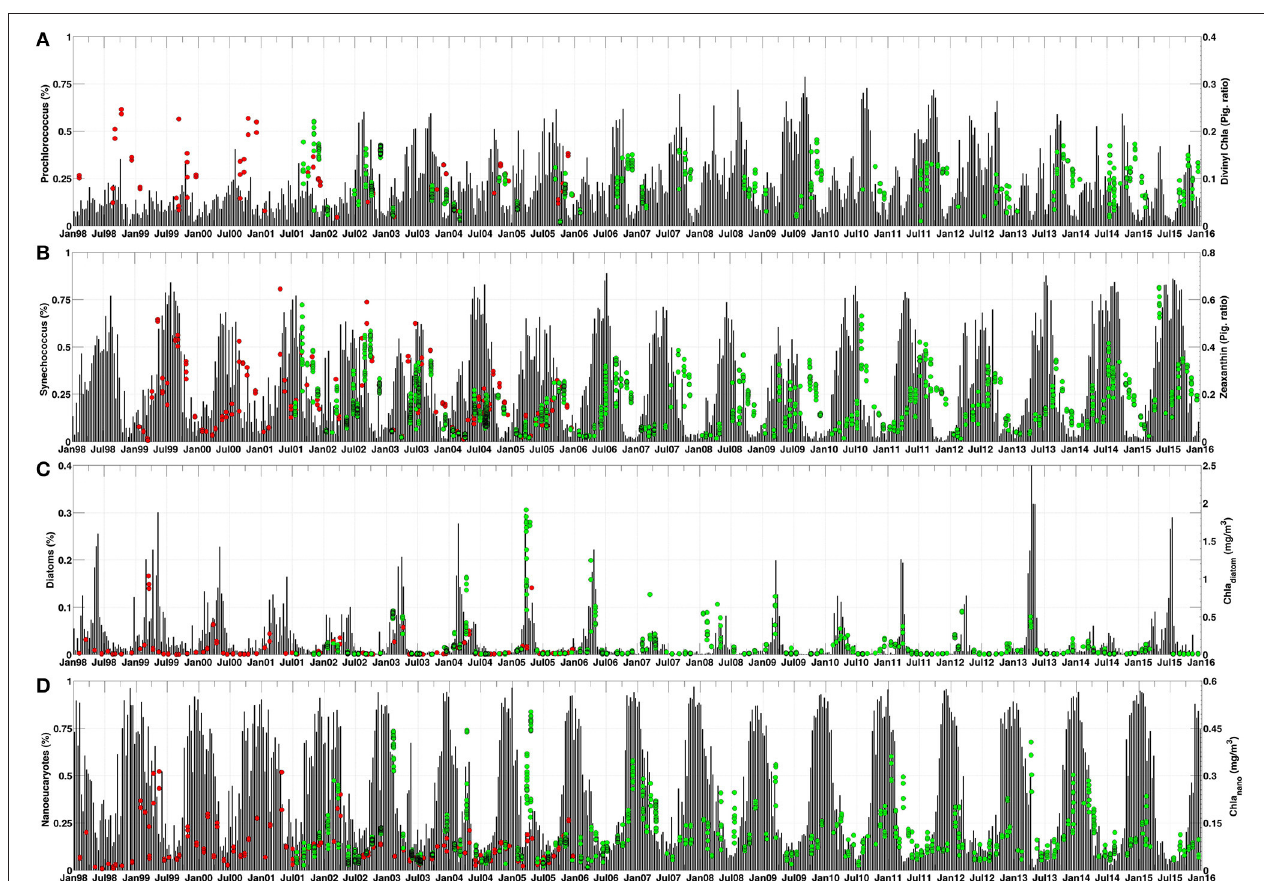
FIGURE 4 | Temporal percentage (10-day) of each PFT (black bars, left axis) and diagnostic pigments (DYFAMED–red dots and BOUSSOLE–green dots, right axis) in the Ligurian Sea. (A) Prochlorococcus and Divinyl-Chl a . (B) Synechococcus and zeaxanthin. (C) Diatoms and Chl a diatom . (C) Nanoeucaryotes and Chl a nano .